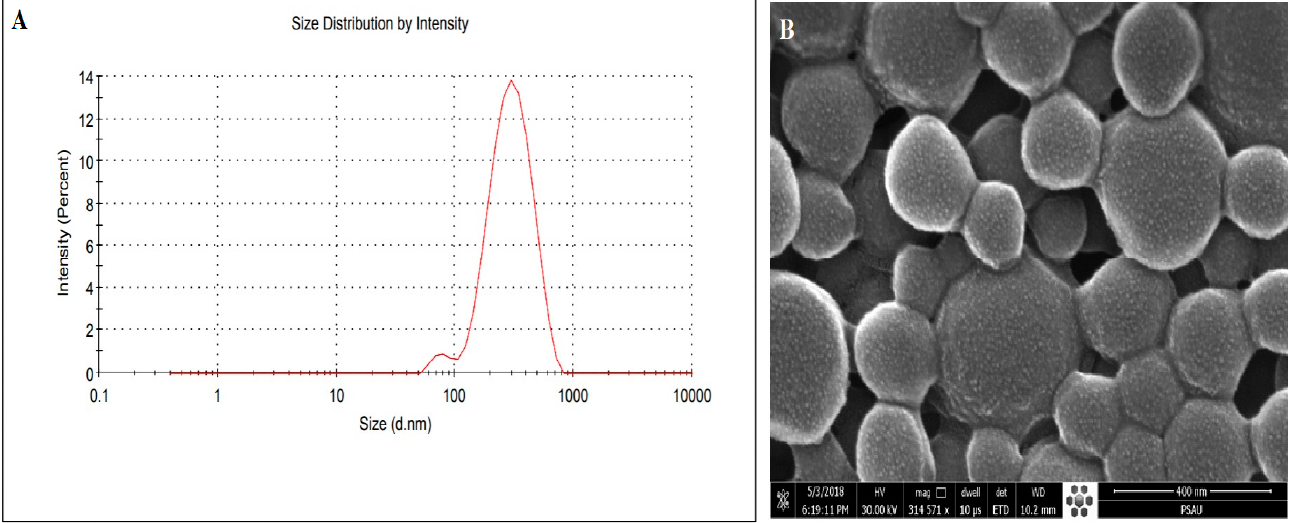
Figure 5. Size distribution plot derived by DLS method ( A ) and SEM images ( B ) of optimised li- pid-polymer nanoparticle system (B-PLN4).